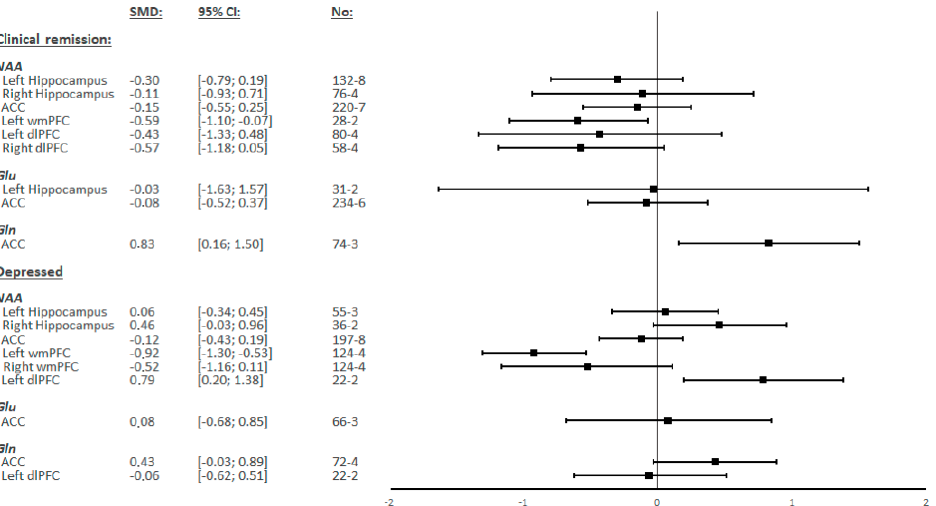
Figure 2. Summary of Standardized Mean Differences (SMDs) and their confidence intervals (95% CI) for each metabolite in each of the different regions by the mood status of bipolar patients.